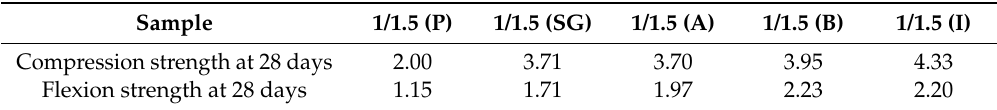
Table 4. Mechanical resistance to compression and flexion at 28 days in samples (1/1.5) with different PU waste.